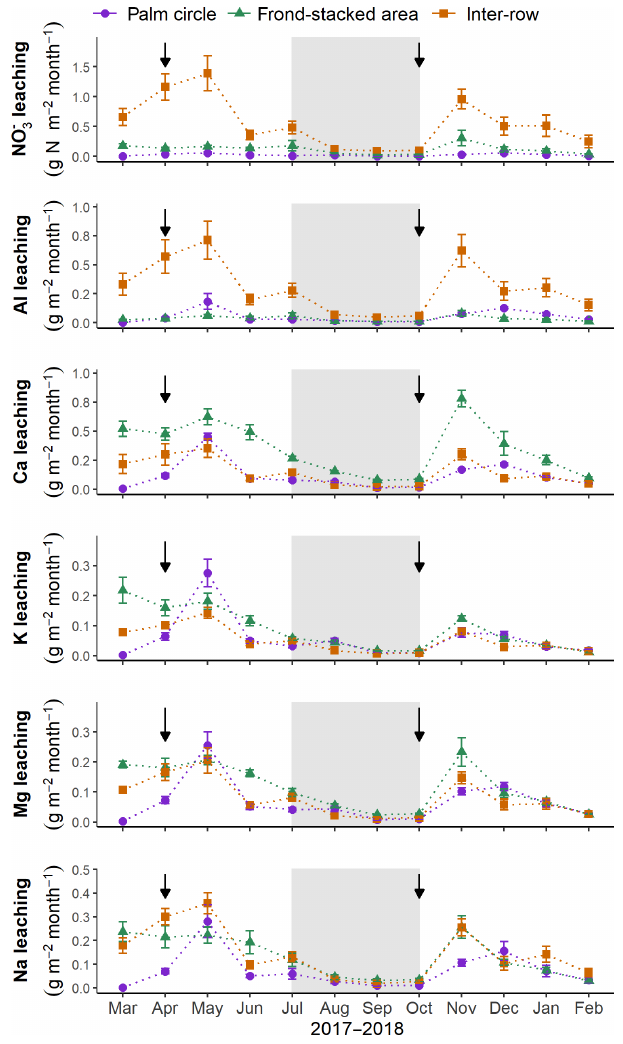
Figure 4. Monthly leaching losses at 1.5m depth (mean ± standard errors, n = 4 plots) for each management zone. Black arrows indi- cate fertilizer applications, and the gray shaded areas represent the dry season (precipitation less than 140mmmonth − 1